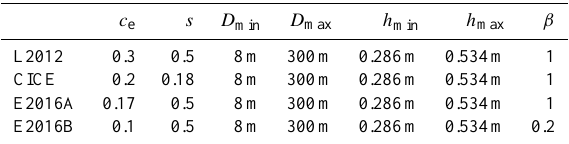
Table 1. Parameter settings for the form drag component of the L2012 scheme (Lüpkes et al., 2012): as recommended in L2012, as used in CICE (Tsamados et al., 2014), and as recommended here (E2016A and E2016B).